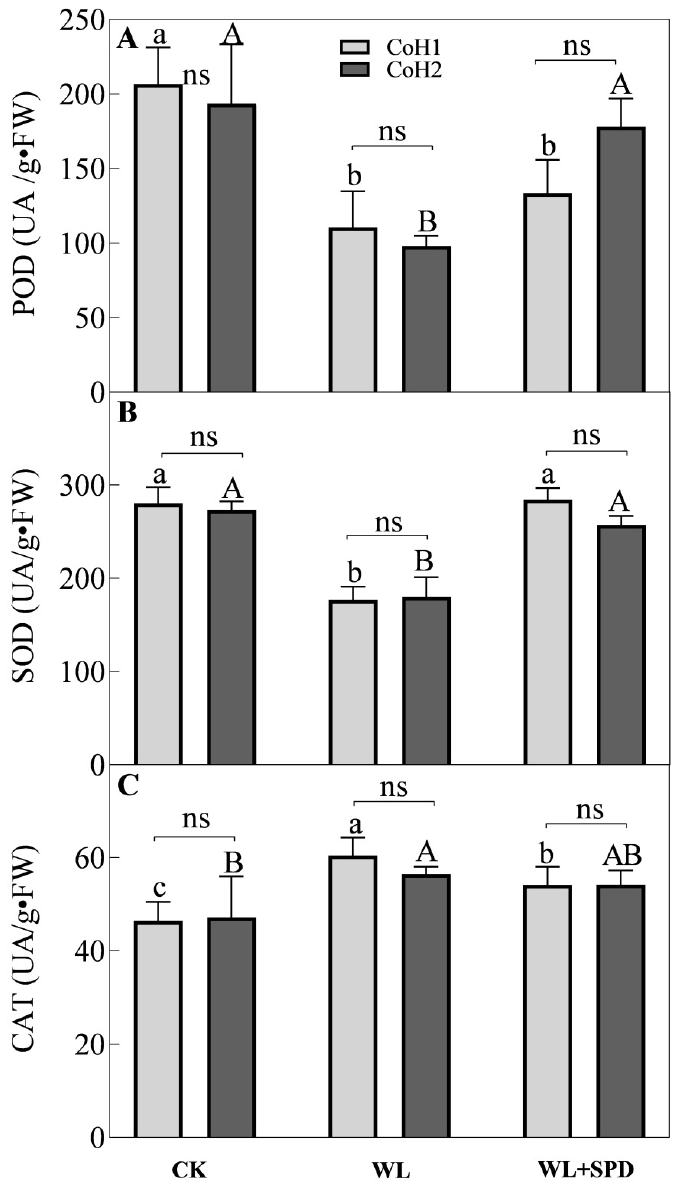
Figure 5. POD ( A ), SOD ( B ), and CAT ( C ) activities in C . oleifera under WL and exposed to SPD. The bars on the top show SE (n = 5), and different lowercases and uppercases indicate significant differences among CK, WL, and WL + SPD treatments within each species according to Tukey’s multiple comparison test, respectively ( p < 0.05). The signs such as ns in the figures concern the signif- icance difference between the same treatment for CoH1 and CoH2 ( ns , Not significant). CK: control; WL: waterlogging; SPD: